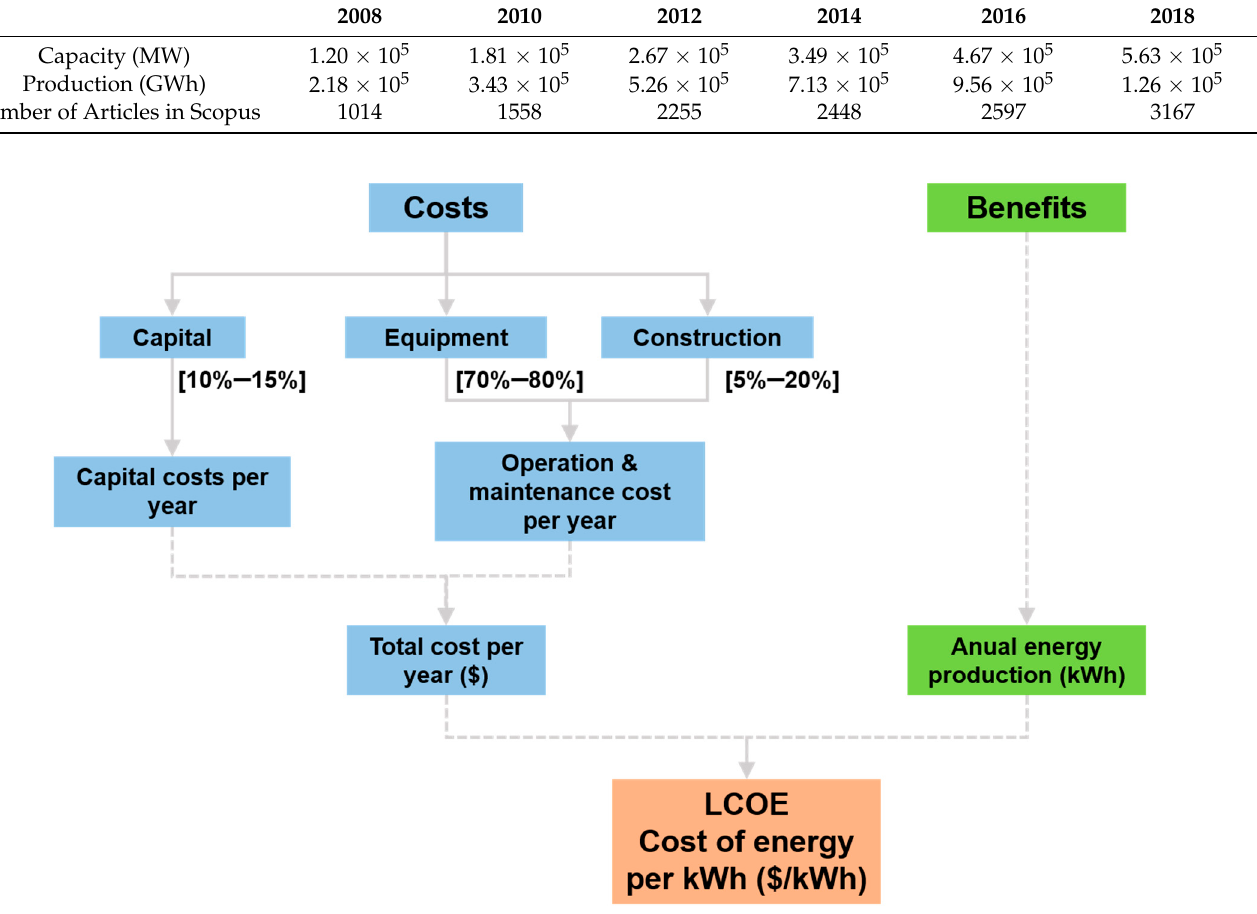
Figure 1. The economics of wind energy.